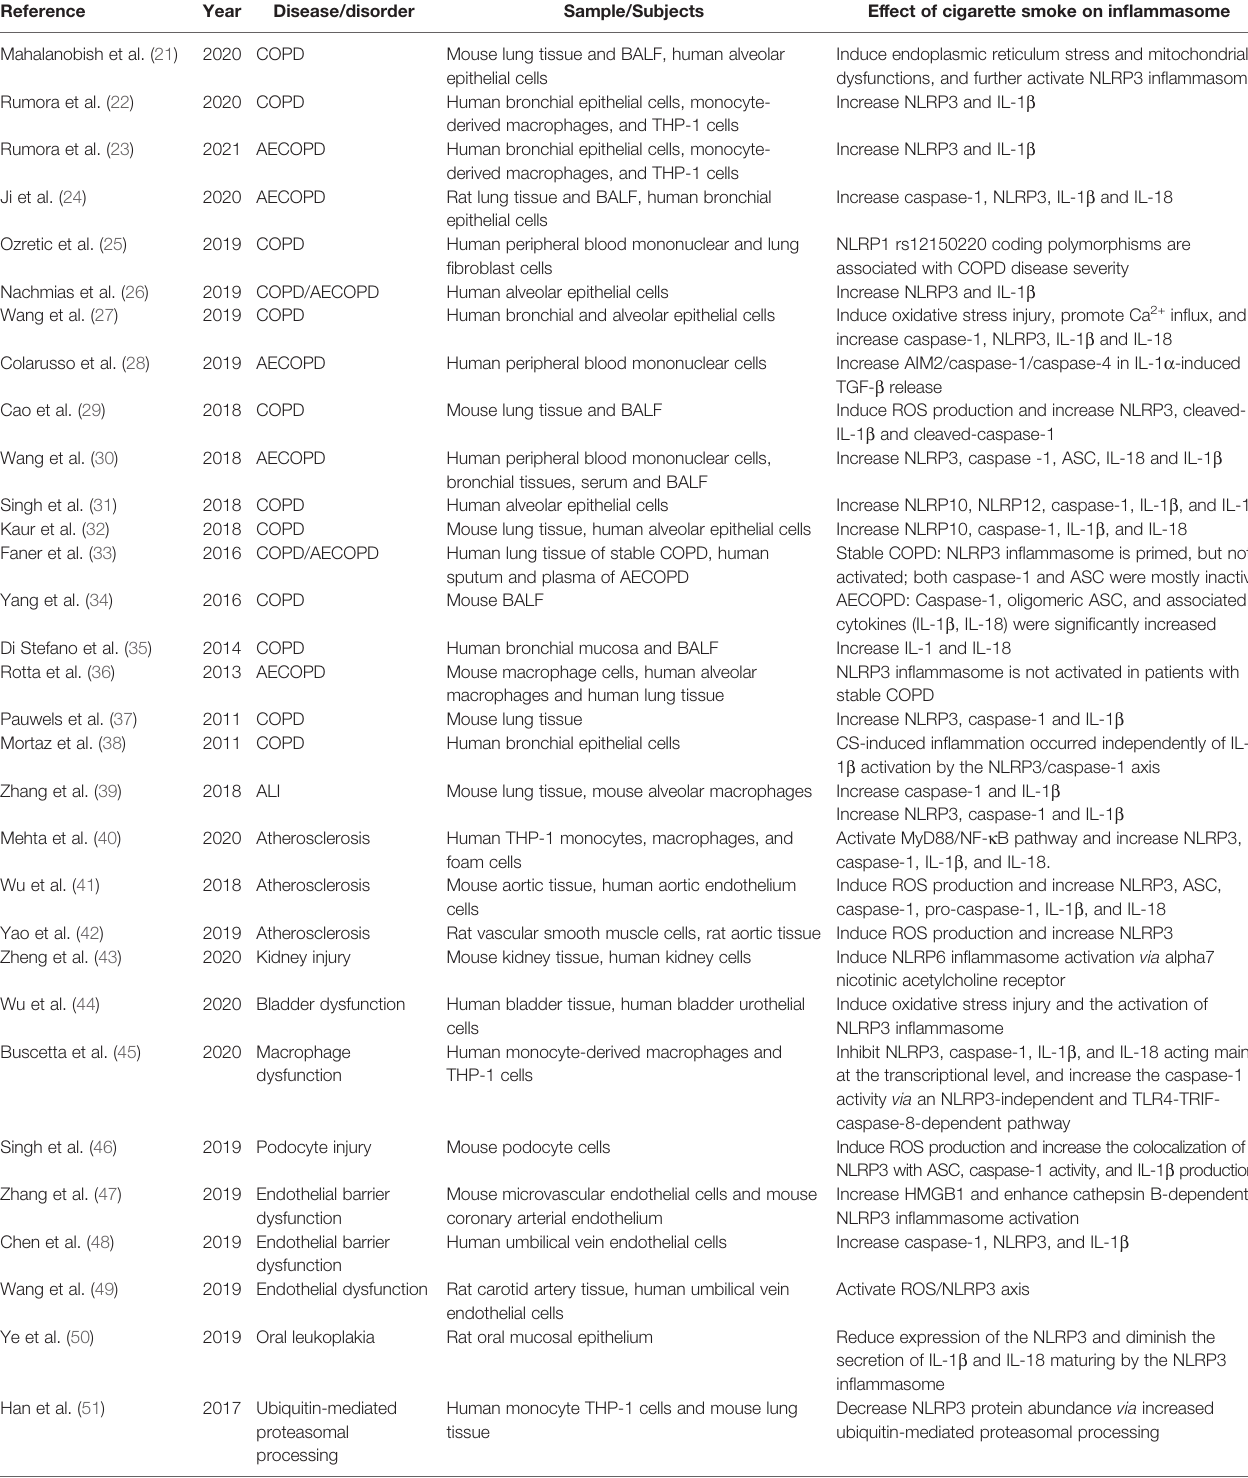
TABLE 1 | Roles of in fl ammasome in cigarette smoke-related diseases and physiopathological